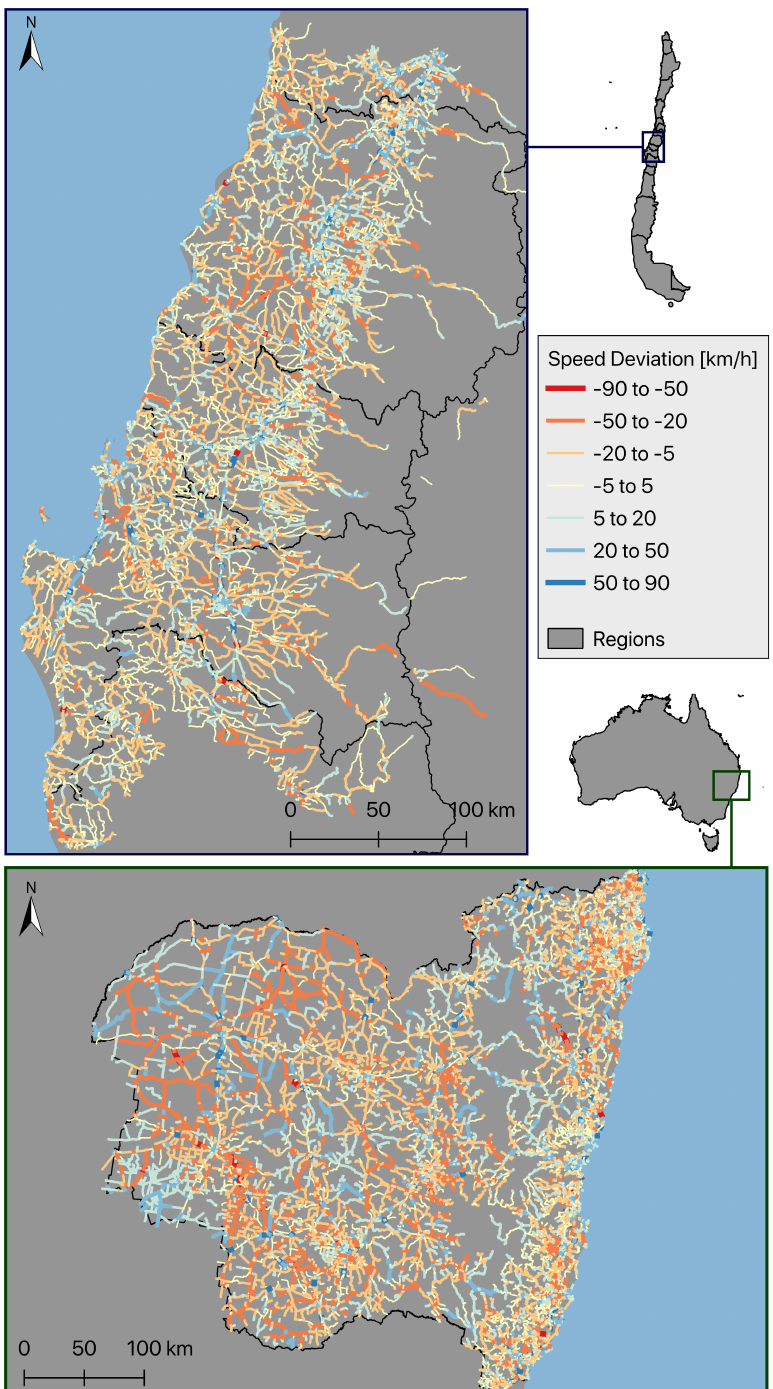
Figure 8. Map of the difference between calculated speed and reference speed in the BM regions in Chile ( above ) and in NNSW in Australia ( below ). Negative values (red and orange) signify lower estimated speed values than reference speed